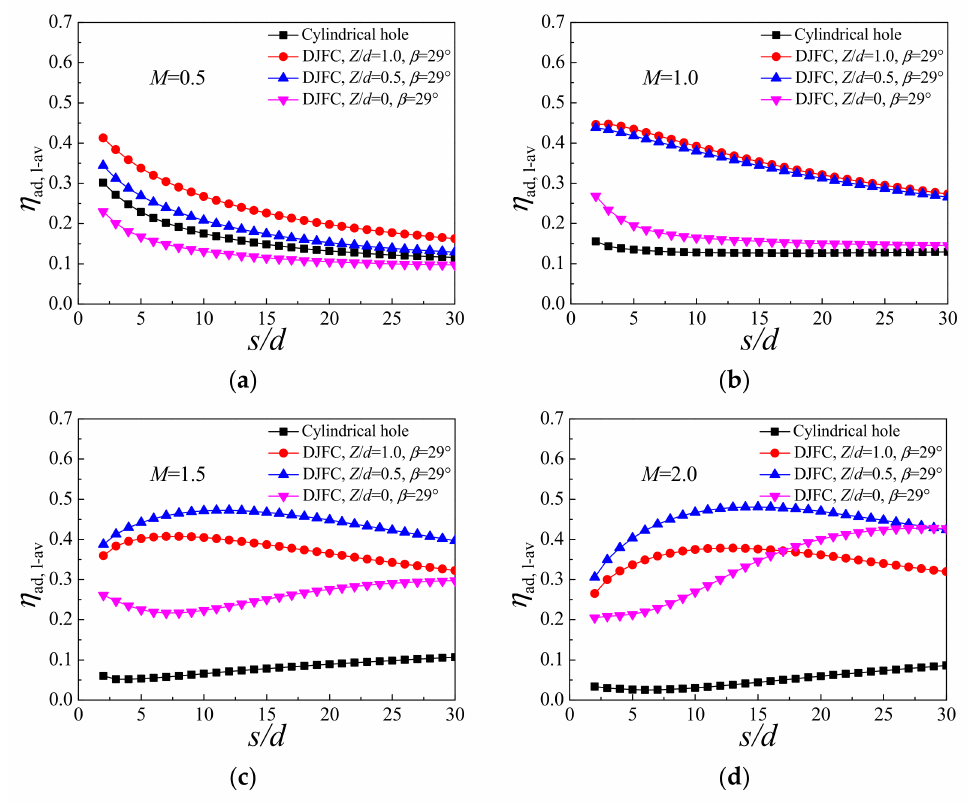
Figure 14. Effect of spanwise spacing on laterally averaged film cooling effectiveness on the pressure surface. ( a ) M = 0.5, ( b ) M = 1.0, ( c ) M = 1.5, ( d ) M = 2.0.